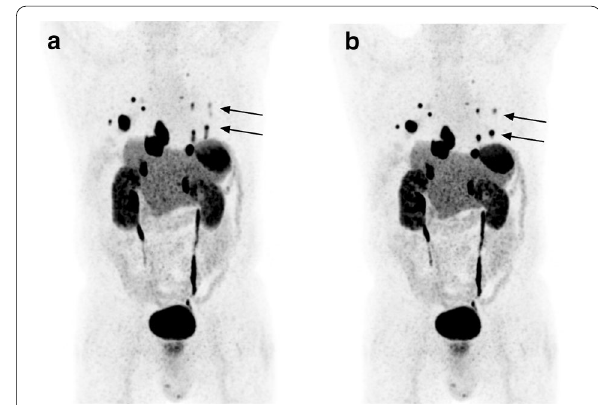
Fig. 4 Anterior maximum intensity projections of a non-gated ( a ) and gated ( b ) [ 68 Ga]Ga-DOTATOC PET examination in a patient with a rectal neuroendocrine tumour. Multiple lesions in the lung, with large blurring effects caused by respiratory motion are indicated by arrows. Both images have identical SUV max grey scales of 0–15